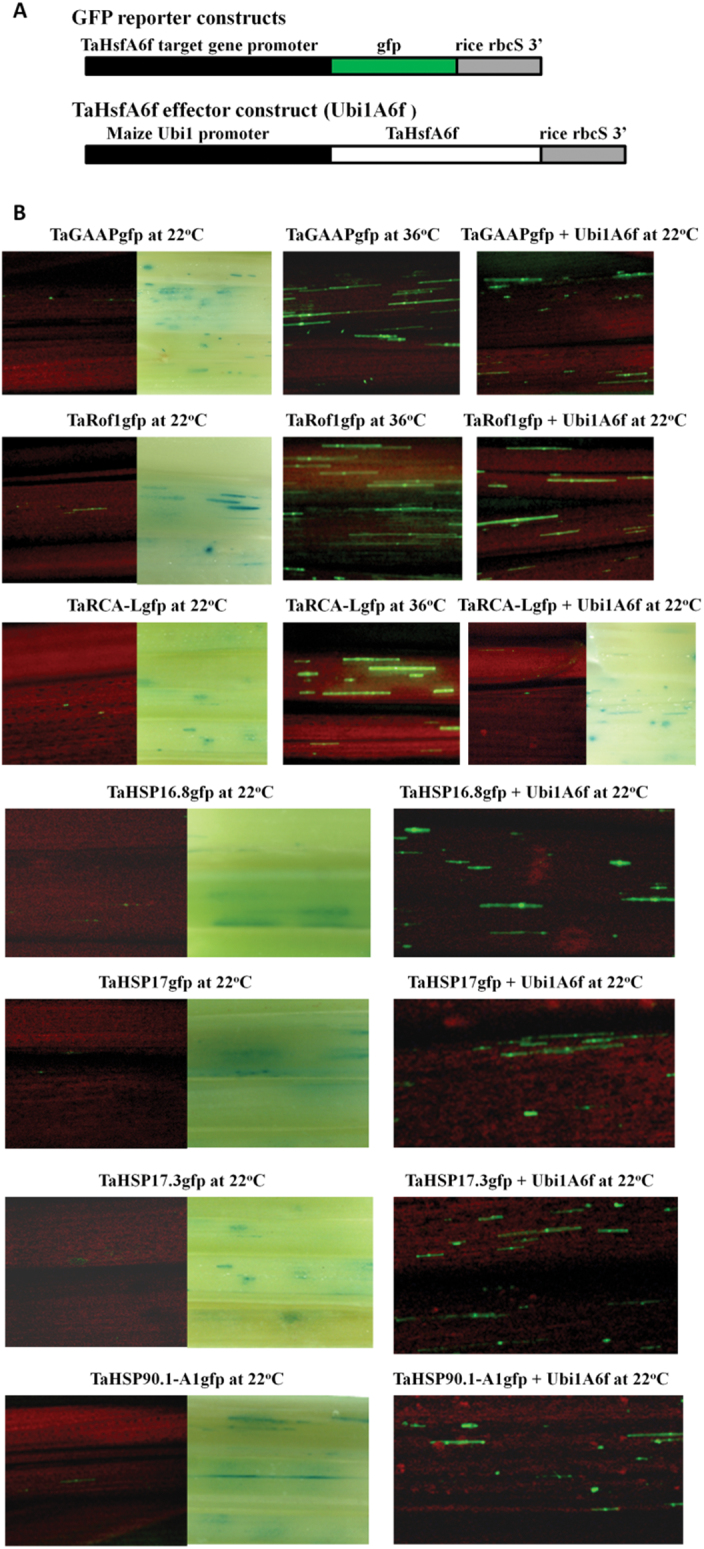
Transactivation analysis of GFP reporter genes driven by the promoters of TaHsfA6f target genes in wheat seedlings. (A) Reporter and effector constructs. (B) Transactivation analysis. GFP foci (green) indicate GFP reporter gene expression. Blue foci resulted from the expression of a co-introduced Ubi1:GUS+ reporter and indicate that tissue sections were transformed with these constructs. The red background is the fluorescence from shoot chlorophyll. The GFP expression of all these reporter constructs was induced at 36 °C, including those driven by TaHSP promoters (Supplementary Fig. S2). The TaHsfA6f effector construct activated the expression of reporter genes driven by TaGAAP, TaRof1, and TaHSP promoters, but not TaRCA-L promoter at 22 °C. Illustration of GUS foci is given only when GFP reporter expression is essentially undetectable in the tissue section.